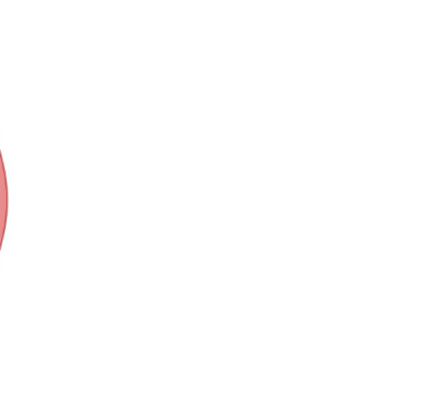
Figure 10. Comparison between the EH-associated genes identified in the GWAS and text mining analysis.